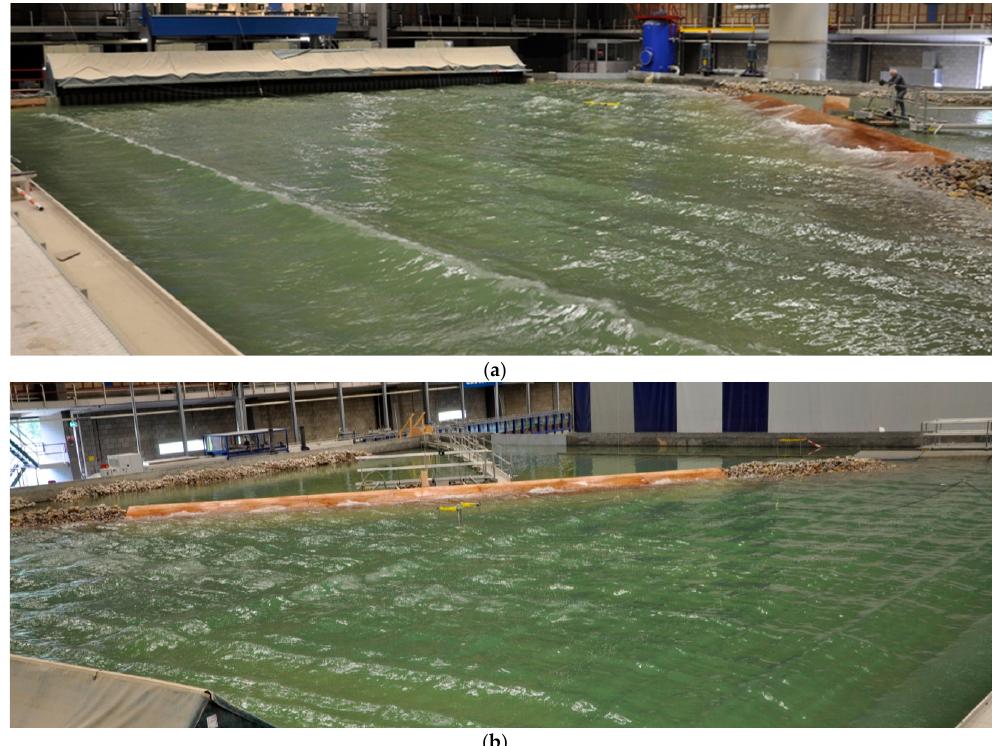
Figure 3. Wave basin tests with waves from two directions; ( a ) two wave generators with structure at the right, ( b ) two sea states approaching the structure under 45 ° .